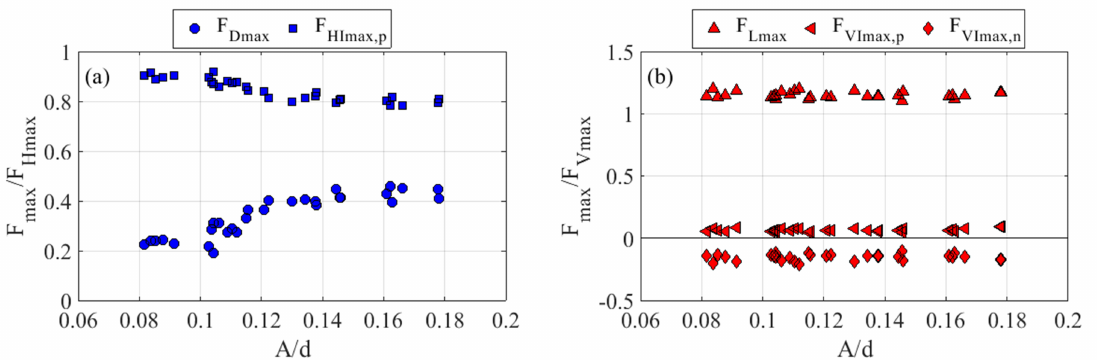
Figure 11. ( a ) Peaks of experimental Morison force components vs. A / d : positive drag F Dmax and positive inertia F HImax , p ; ( b ) Peaks of experimental transverse force components vs. A / d : positive lift F Lmax , positive inertia F VImax , p , and negative inertia F VImax , n